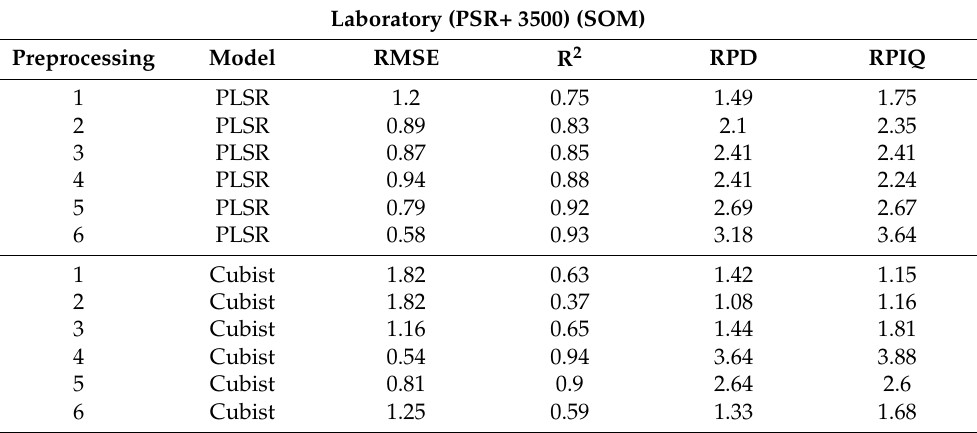
Table A1. Statistical evaluation of the models used to predict the soil organic matter (SOM) content from the laboratory